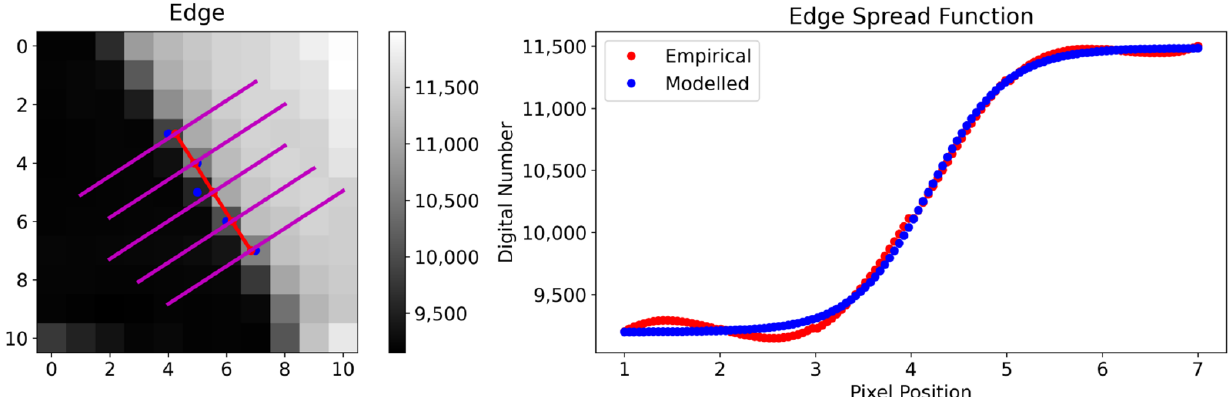
Figure 4. The box displayed on the left-hand side displays the sub-pixel linear fitting (red line with point markers) of the original edge (blue points, that represents the centroids of the edge’s pixels) and the perpendicular transects (purple lines). The box displayed on the right-hand side depicts the ESF computation: the averaged/empirical ESF is shown in red, the modeled (fitted) ESF is displayed in blue.